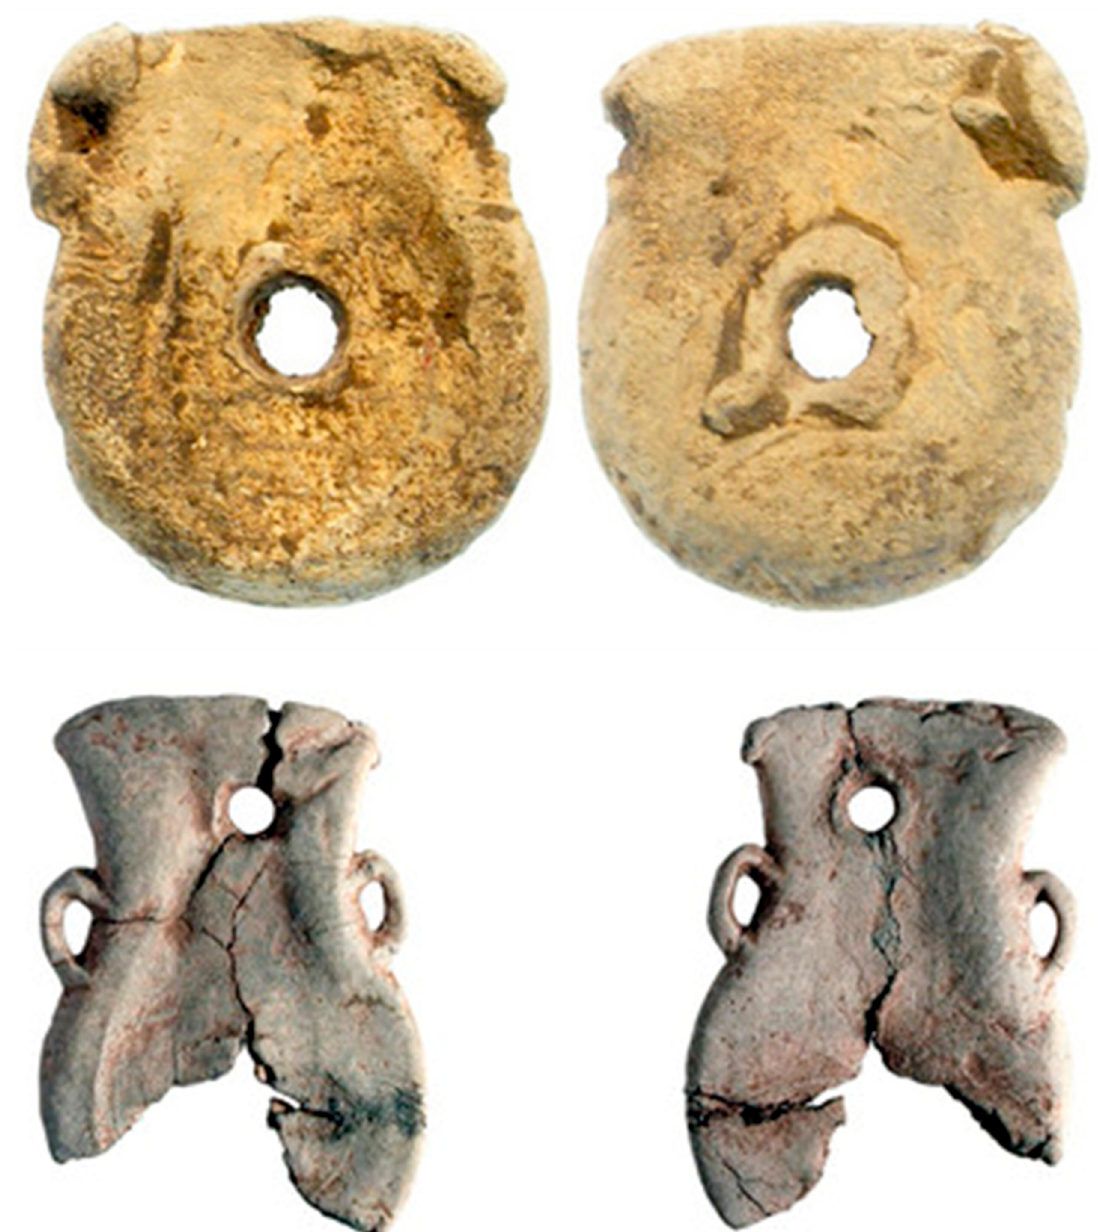
Figure 2. Pilgrim ampullae and badges with nail holes. 13th–15th century, tin / lead. Photos: Portable Antiquities Scheme.